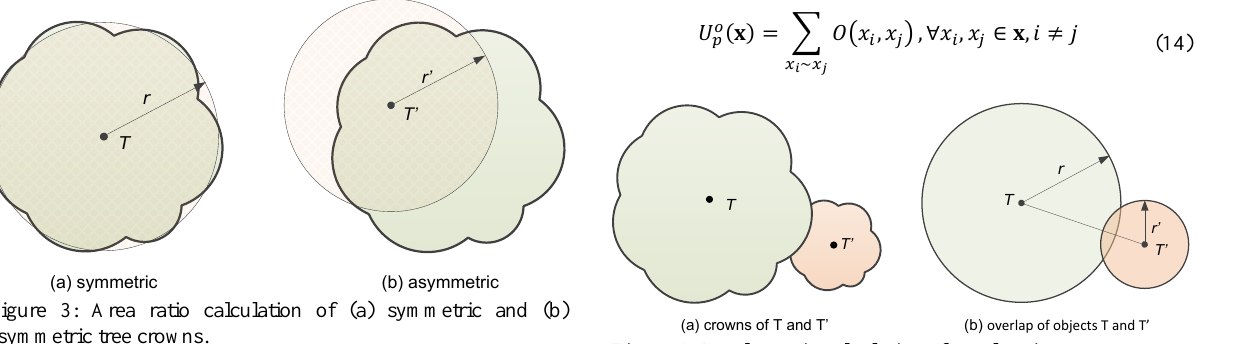
Figure 4: Overlap ratio calculation of overlapping tree